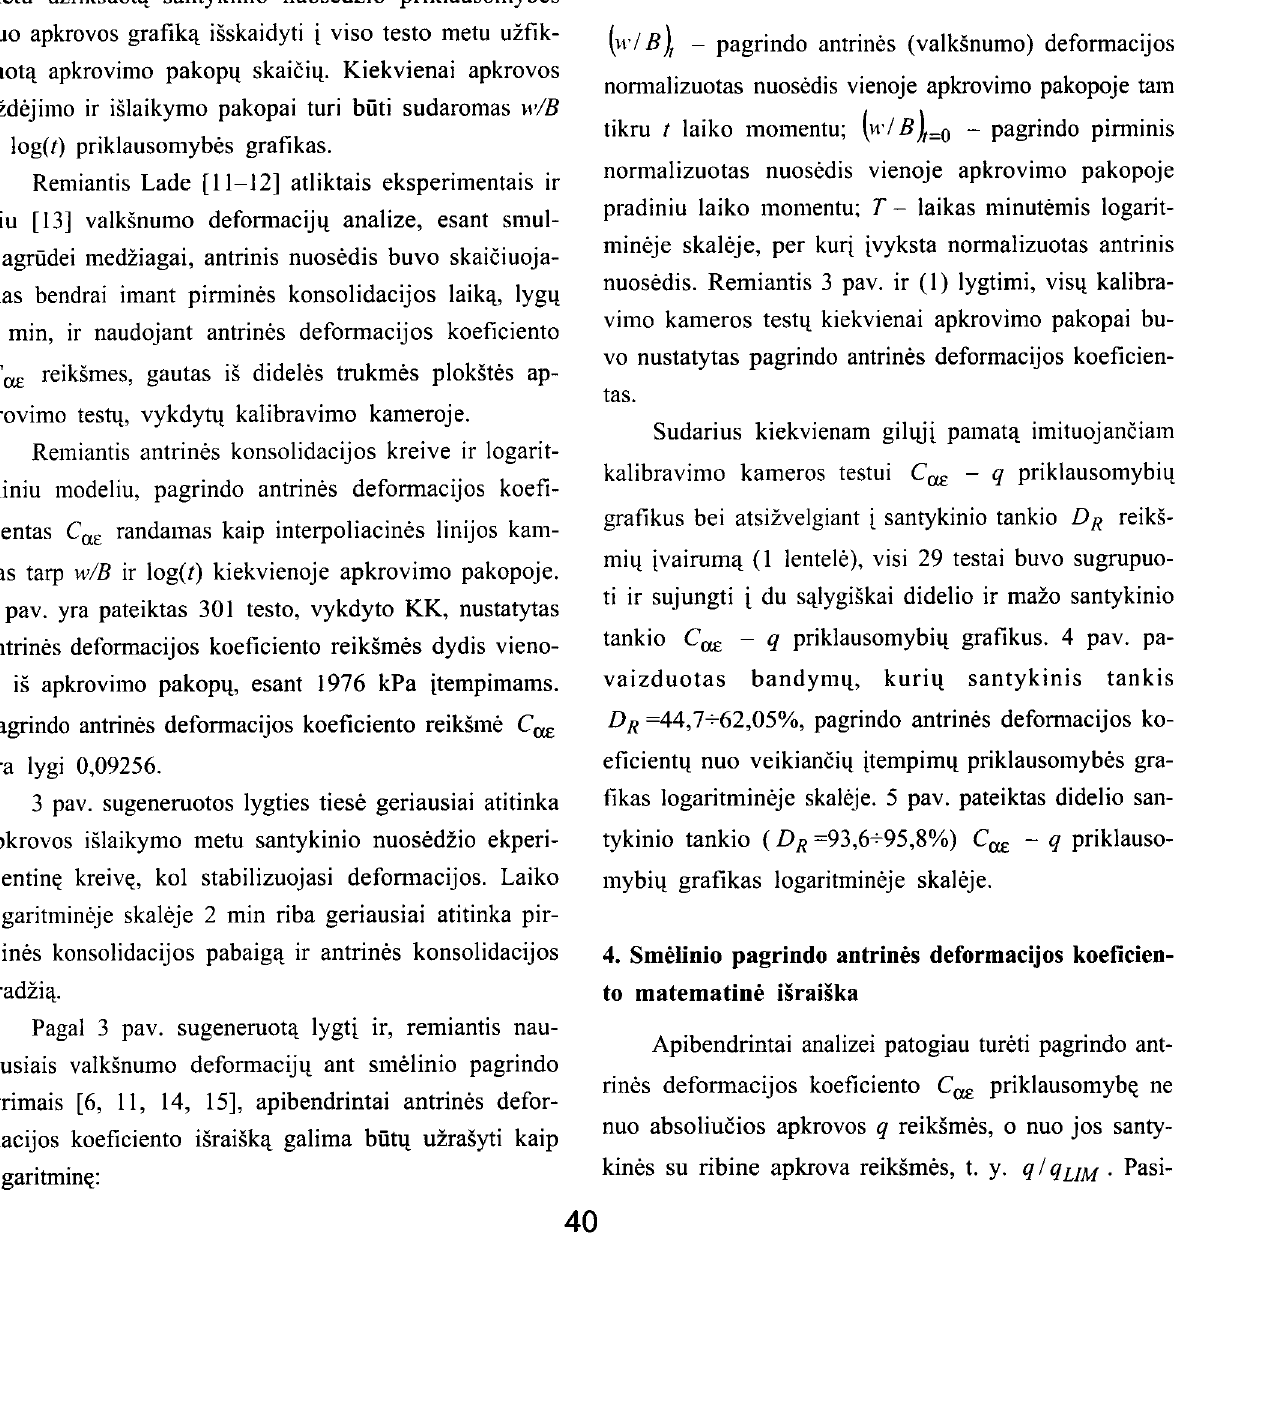
Fig 2. Deep plate loading test (No 301) in calibration chamber